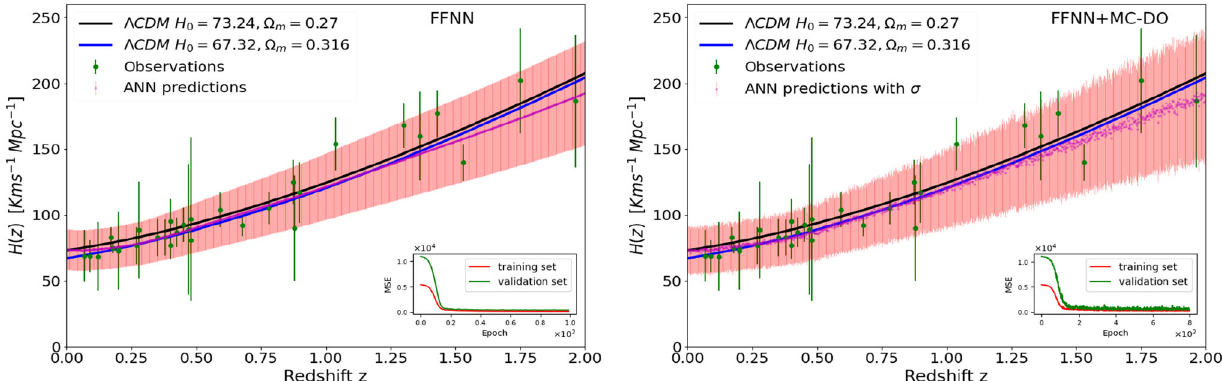
Fig. 2 HubbledistancereconstructionwithFFNNs.Left:Purplepoints represent the FFNN predictions for H ( z ) along with their error bars in red color. Right: Similarly to FFNN but adding MC-DO, we executed 100 times the Monte Carlo dropout to compute the uncertainties of the predictions. Therefore the purple points are the average predictions of the MC-DO executions, and the red error bars are the uncertainties of